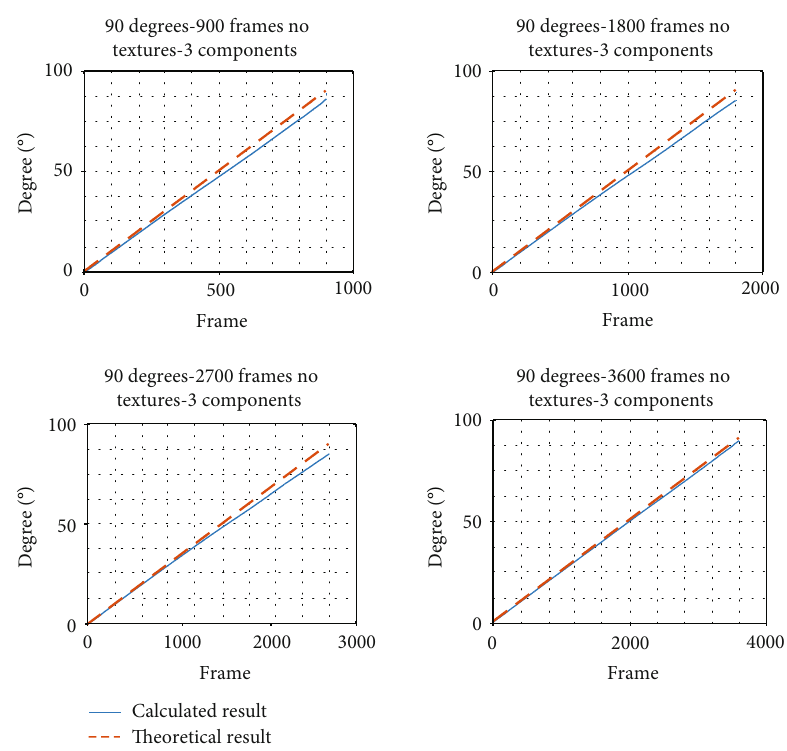
Figure 8: Angle estimation of model (a) under di ff erent imaging speeds (rotation angle of 90